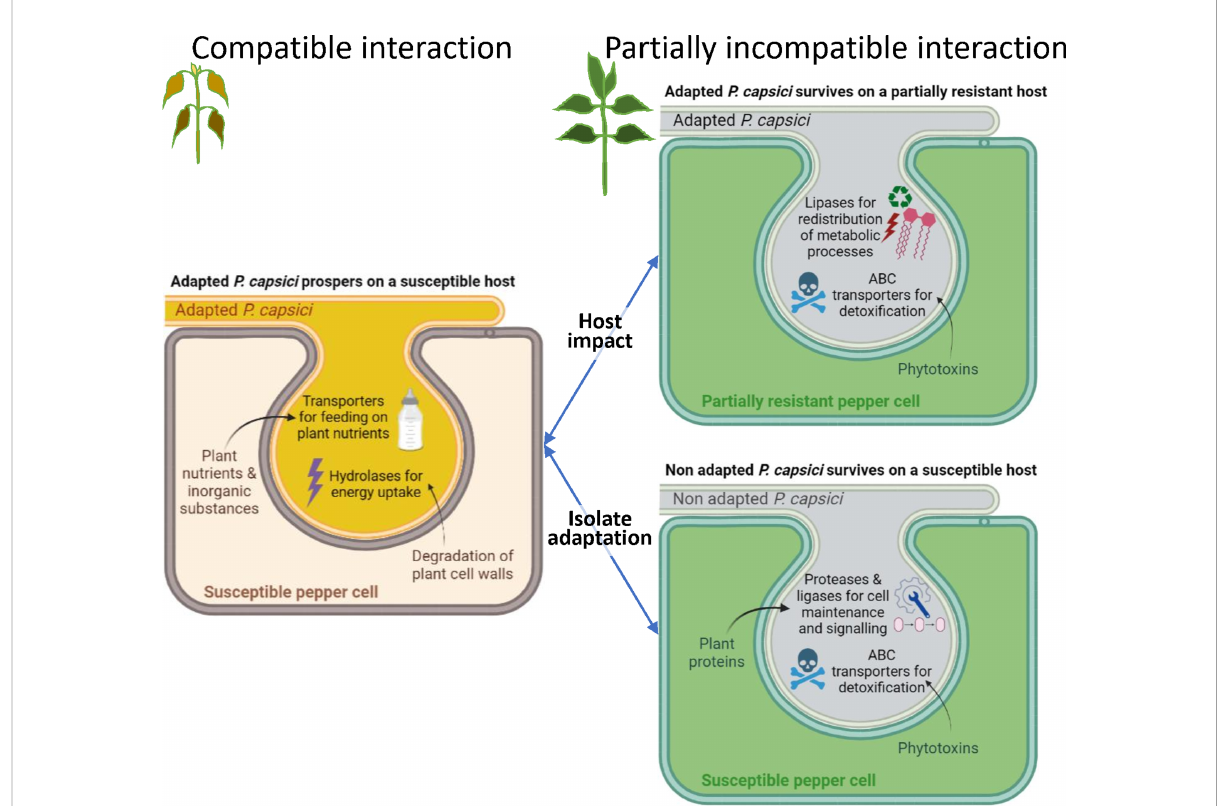
FIGURE 8 Simpli fi ed model of major molecular mechanisms in pepper – Phytophthora capsici interaction based on analysis of RNA-seq data at 24 hpi. The S_A interaction between the susceptible host and the adapted isolate leads to a compatible interaction that allows P. capsici to thrive by feeding on plant nutrients and absorbing energy produced by the degradation of plant cell walls, through exchanges that would occur in the haustorium. When the host is partially resistant or the isolate is non-adapted, this leads to a partially incompatible interaction, such as interactions R_A, S_N or R_N. In the R_A interaction, P. capsici recycles its own resources through lipid metabolism and detoxi fi es phytoalexins to strive for its survival. In the S_N interaction, P. capsici also detoxi fi es phytoalexins and activates protein metabolism for maintenance of its own cells. R_N is not represented here since our study revealed only four genes that are differentially expressed with S_N. This tentative model simply presents the hypotheses resulting from our study and is destined to be completed or modi fi ed to tend towards the complexity of the natural system, thanks to future analyses carried out by the whole scienti fi c